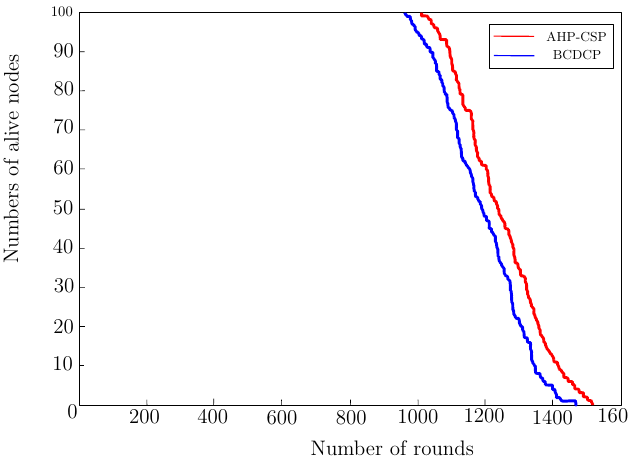
Figure 5. A comparison between AHP-CSP and the Base station Controlled Dynamic Clustering Protocol (BCDCP) by the number of alive nodes (system